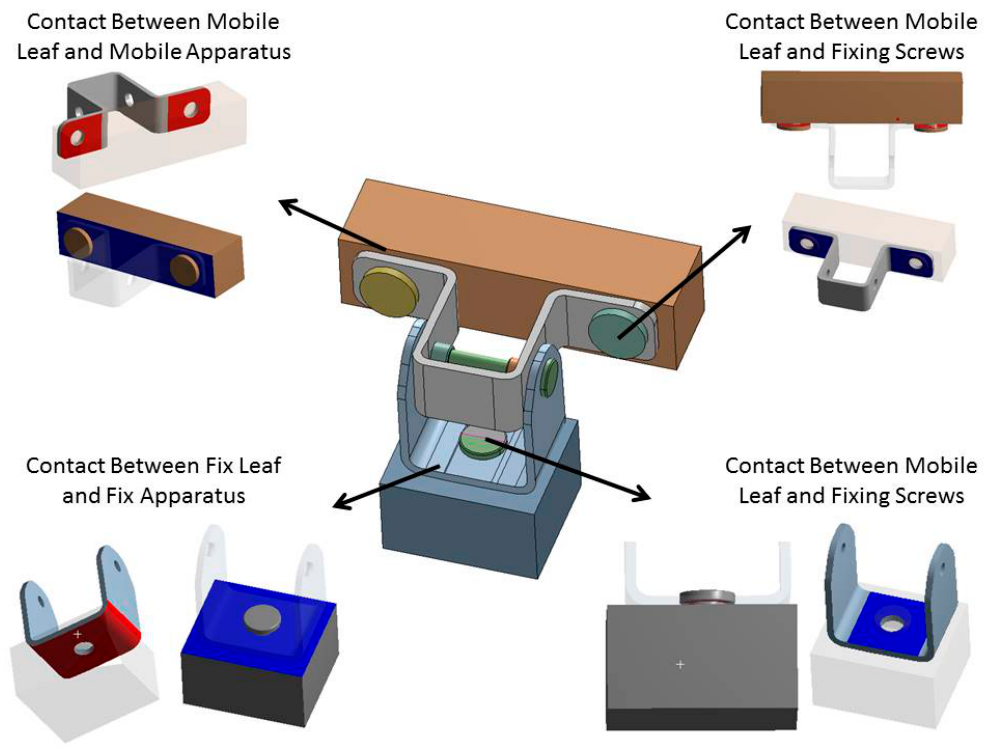
Figure 13. Common contact regions for friction evaluation.